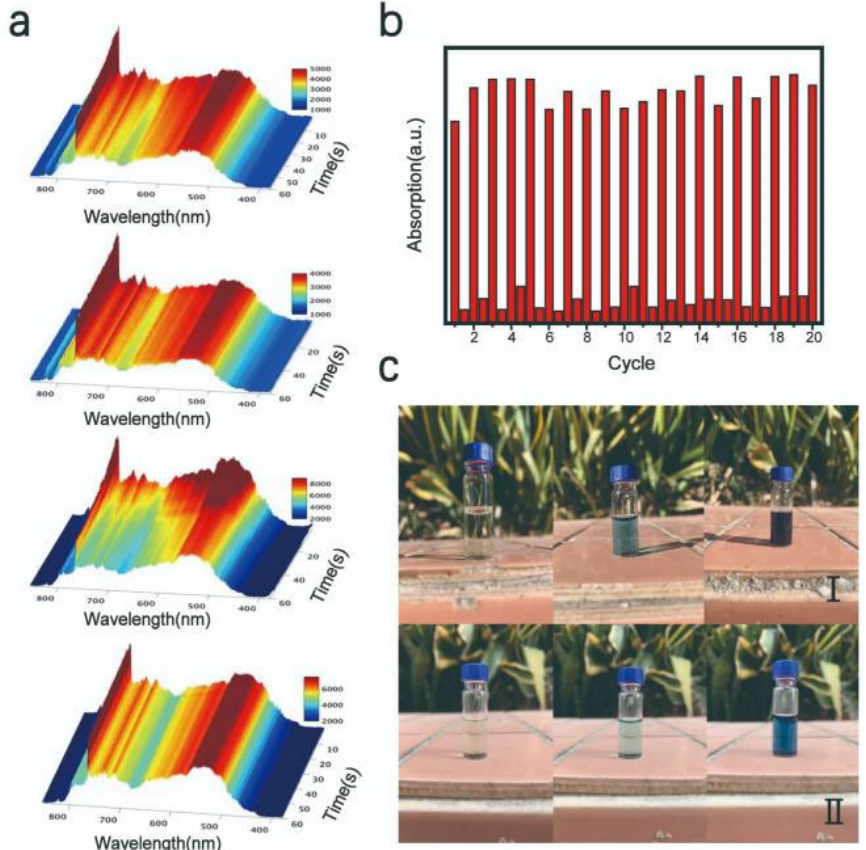
Figure 6. ( a ) Spectra of the Fiber Optic spectrometer. ( b ) Cycle stability test. ( c ) Discoloration per ‐ formance of MoO 3 ‐ x nanostructures in sunny weather ( Ⅰ ) and cloudy weather ( Ⅱ ).